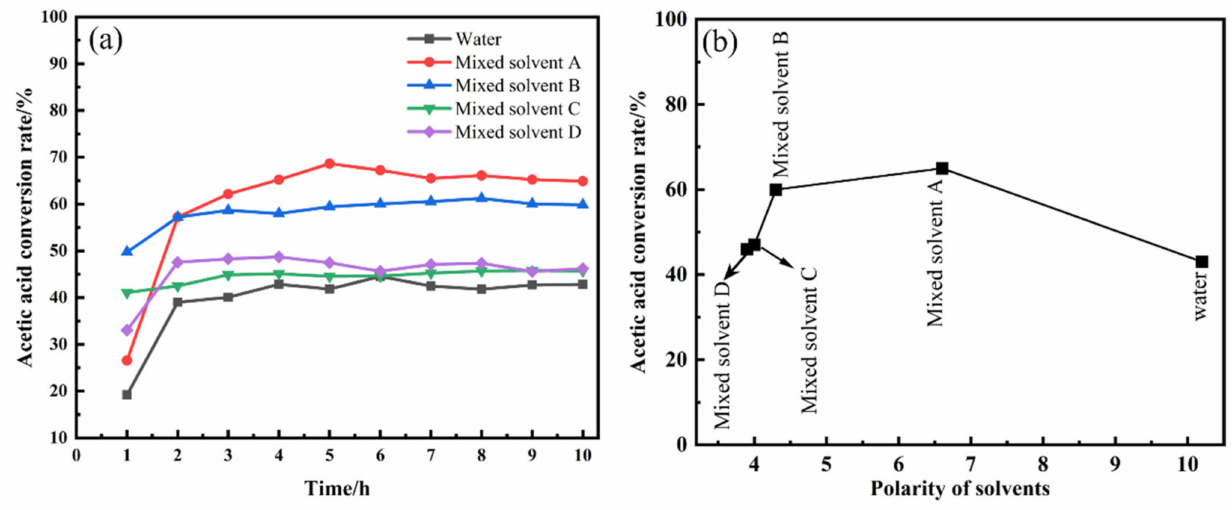
Figure 1. ( a ) Acetic acid conversion using different solvents for catalyst preparation; ( b ) acetic acid conversion as a function of the polarity of the solvent used to prepare the